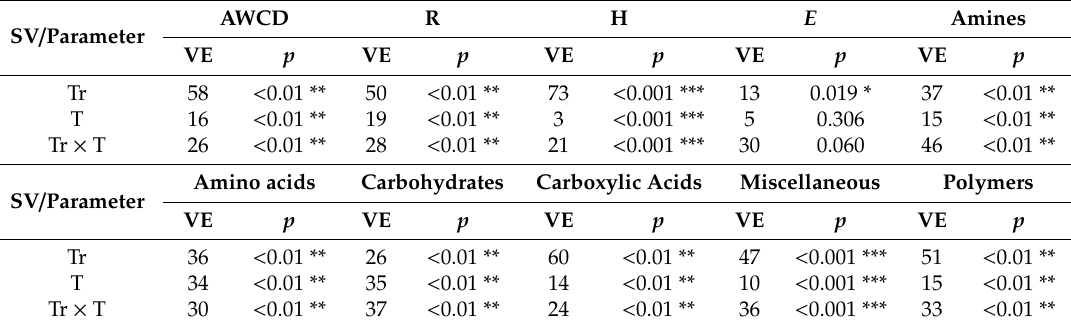
Table 7. Results of the two-way ANOVA for the resistance (RS) indices.